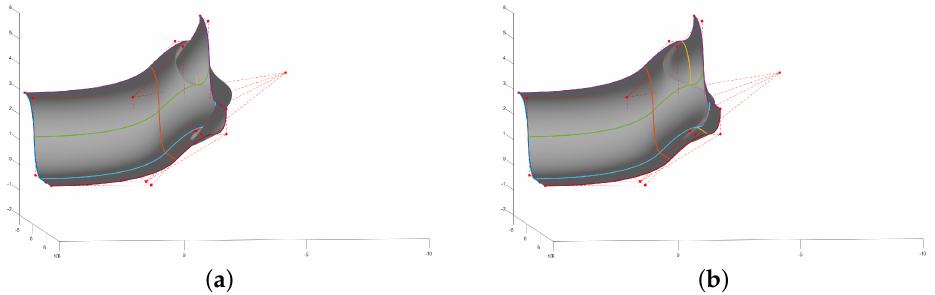
0,0,0, 1 , 2 ,1,1,1 and 3 3 { }